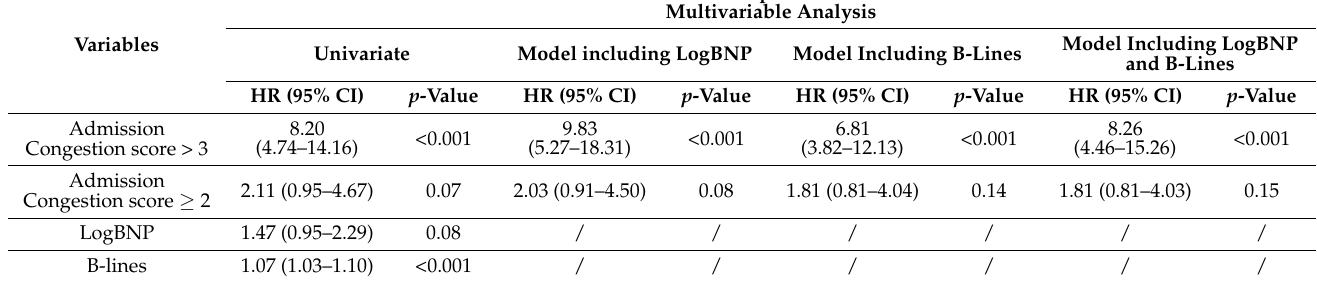
Table 3. Univariate and Multivariable analysis for admission clinical congestion, B-lines, and BNP including three combined models.